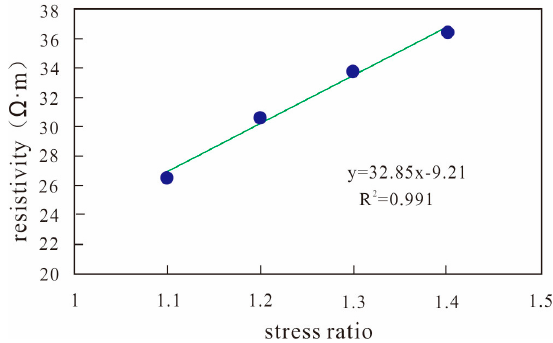
Figure 8. Relationship curve between resistivity and stress ratio. (2)